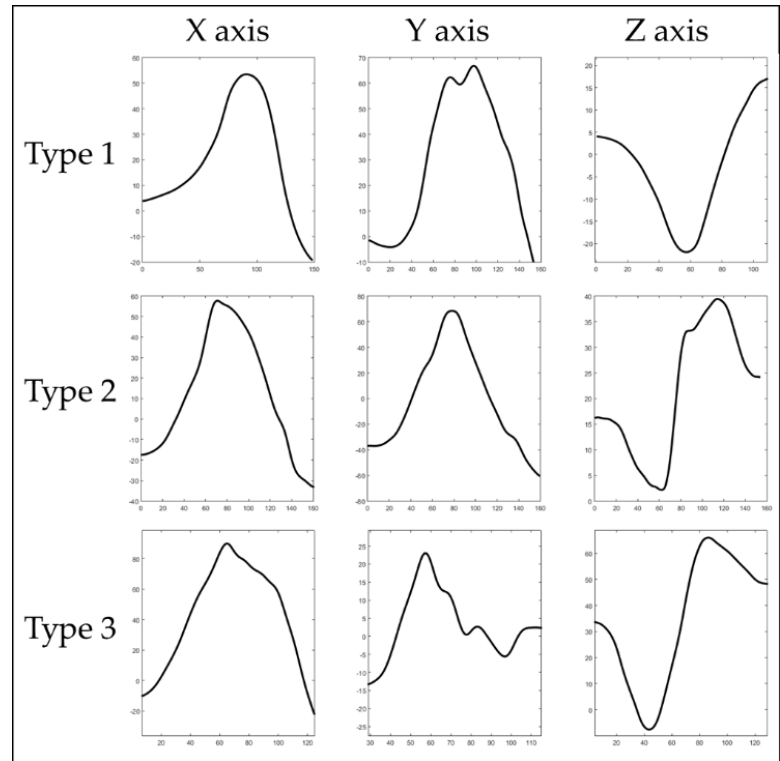
Figure A7. Orthogonal types 1, 2, and 3.